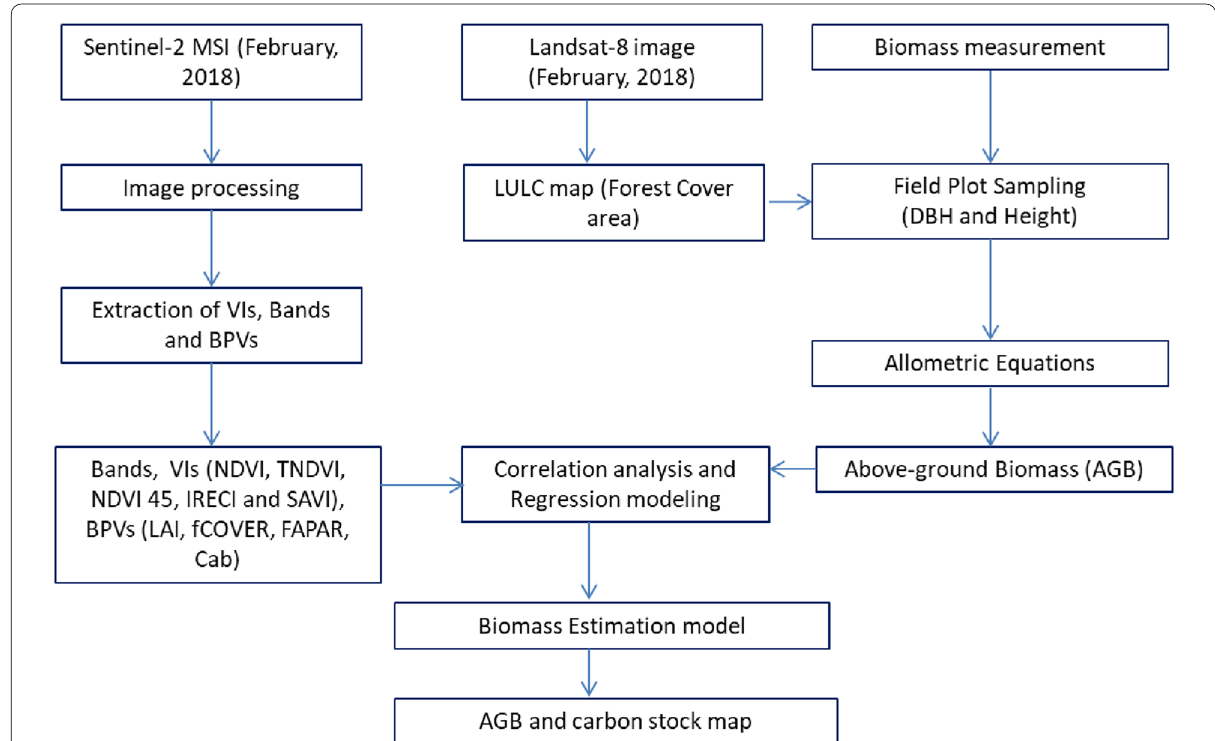
Fig. 4 Methodological flow chart showing the data sources, analytical procedures and final outputs